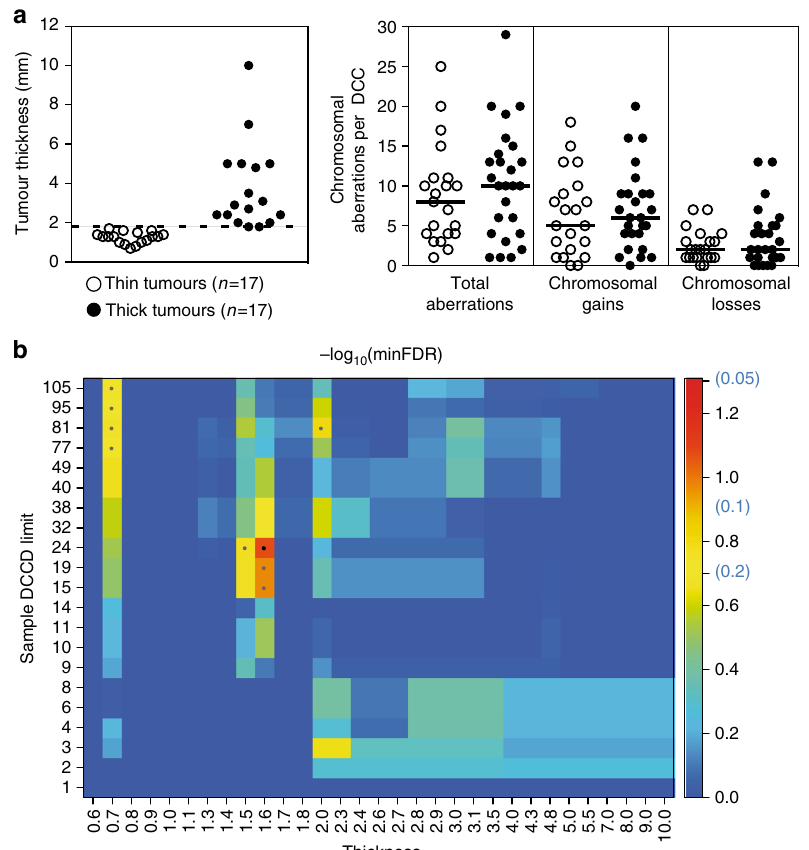
Fig. 5 Molecular analysis of DCCs at dissemination. a Left: Separation of primary melanomas according to median thickness into thin ( < 1.8 mm) and thick ( ≥ 1.8 mm) tumours, from which DCCs were analysed. Right: Number of chromosomal aberrations per DCC from thin ( n = 17) and thick (n = 17) tumours . b Samples were selected for suggested early arrival in the SLN as indicated by small DCCD values up to 105 and then tested for genomic differences regarding their origin from thick and thin primaries. The y axis speci fi es the DCCD limit up to which samples were included in the analysis, with sample numbers ranging from 6 (DCCD = 1) over 31 (DCCD = 24) to 46 (DCCD = 105). The x axis reports the limiting thickness according to which samples were split regarding their association with thin or thick tumours (set points left of these values). Colour indicates the minimum FDR-adjusted p values (Fisher ’ s exact test) across loci/mutations assessing the largest genomic differences between these two groups. The smallest p value of FDR = 0.084 occurs at DCCD = 24 and thickness = 1.6 mm for locus 18q21 – 23 (black central dot). p values up to FDR = 0.2 are indicated by grey dots and may refer to the loci 18q21 – 23, 1q24 – 44 or 8q23 – 24.3. The colour key includes the non-log-transformed FDR values 0.05, 0.1 and 0.2 in brackets. No signi fi cant